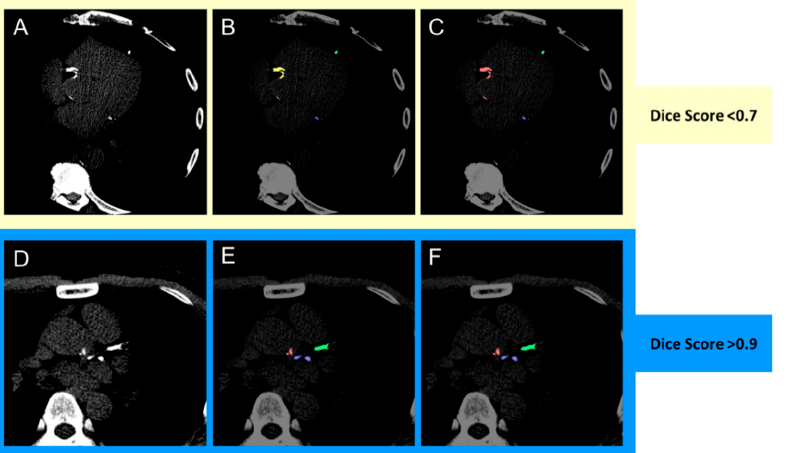
Figure 3. Dice score visualization. ( A , D ) Original image; ( B , E ) ground truth annotation; ( C , F ) deep learning model output. The Dice score is commonly used to gauge the model performance and ranges from 0 to 1, with 1 corresponding to a pixel perfect pixel match between the ground truth annotation. In the images above, the prediction with the lower Dice score ( C ) is due to the model misclassifying right coronary artery calcification (yellow) as aortic calcium (red). The prediction with the higher Dice score ( F ) correctly classifies left anterior descending (green), left circumflex (blue) and aortic calcification (red)